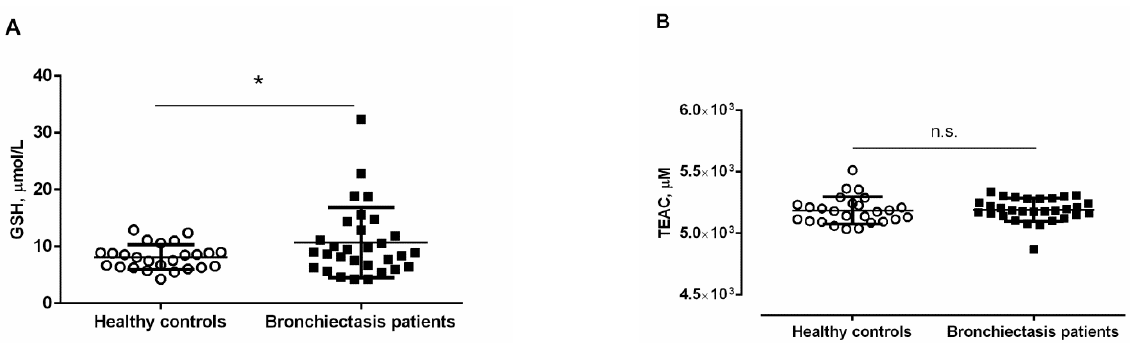
Figure 4. Mean values and standard deviations of plasma ( A ) GSH levels ( µ mol/L) and ( B ) TEAC levels ( µ M) in healthy controls and bronchiectasis patients. Statistical significance: * p ≤ 0.05 between bronchiectasis patients and healthy controls; and n.s., non-significant differences between the two study groups.